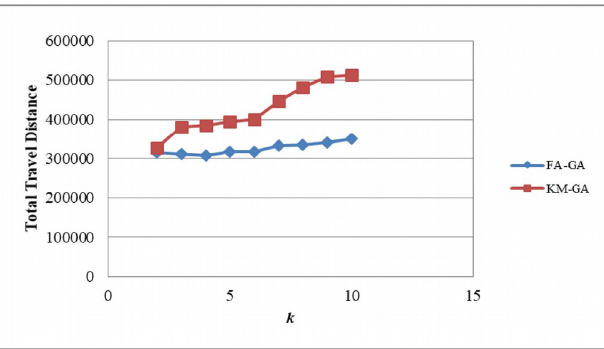
Figure A-4. Total traveling distance vs. k for instance Pr1002